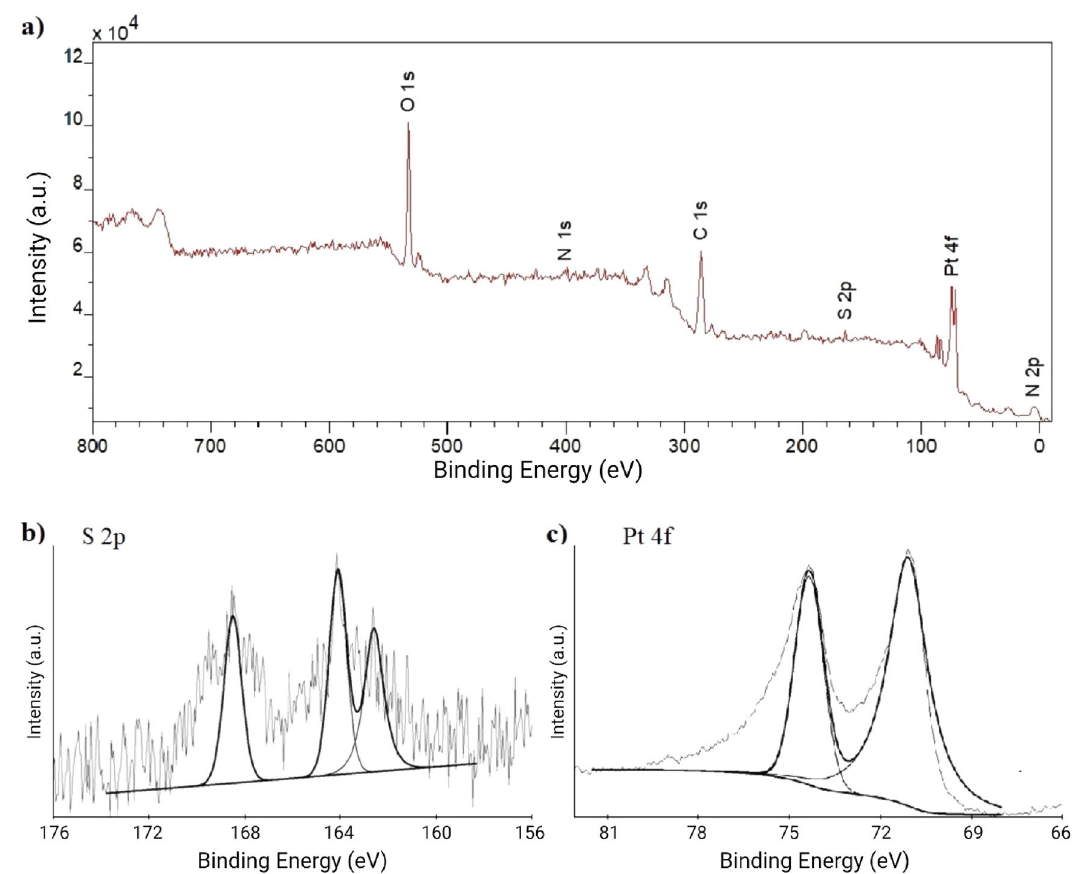
Figure 2. X-ray photoelectron spectroscopy (XPS) analysis. ( a ) survey spectrum, ( b ) S 2 p spectrum, and ( c ) Pt 4 f spectrum showing the successful co-deposition of both ALG-thiomer and Pt onto electrodes. Solid lines with smooth curves are from XPS Peak software used to identify the S 2 p and Pt 4 f peaks.